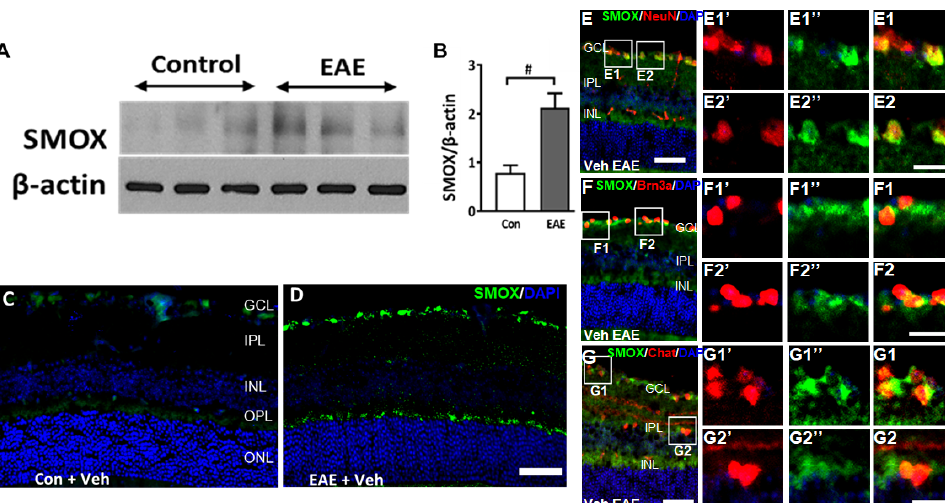
Figure 2. SMOX expression is upregulated in the EAE retina. ( A , B ) Western blot studies showing the upregulation of SMOX expression in EAE retinas compared to control, following 15 days post- induction. Quantification studies show a significantly upregulated level of SMOX in the EAE retina. Results are presented as mean ± SD; # p < 0.05; n = 4–5, representative blots are presented. ( C , D ) Representative immunofluorescence images showing increased expression of SMOX in the vehicle EAE retina as compared to the control. Scale bar 50 μ m. ( E – G ) Colocalization studies showing expression of SMOX in retinal ganglion cells (Brn3a and NeuN), and amacrine cells (ChAT). Scale bar: 50 μ m. Boxed areas represent areas of colocalization and magnified to visualize the expression. Red (1’ and 2’) and green (1’’ and 2”) signals are presented separately to visualize the expression pattern. E1, E2, F1, F2, G1 and G2 show magnified areas of respective colocalization. Scale bar 20 μ m. GCL, ganglion cell layer; INL, inner nuclear layer; IPL, inner plexiform layer; ONL, outer nuclear layer; OPL, outer plexiform layer.